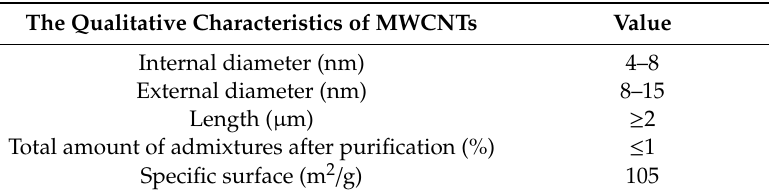
Table 4. Properties of